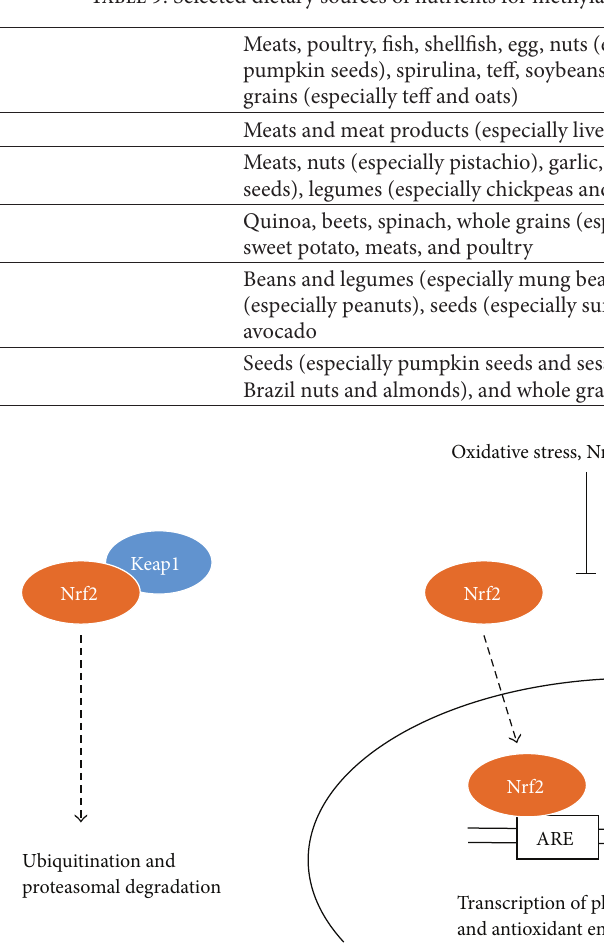
Table 9: Selected dietary sources of nutrients for methylation support (adapted from [111]).